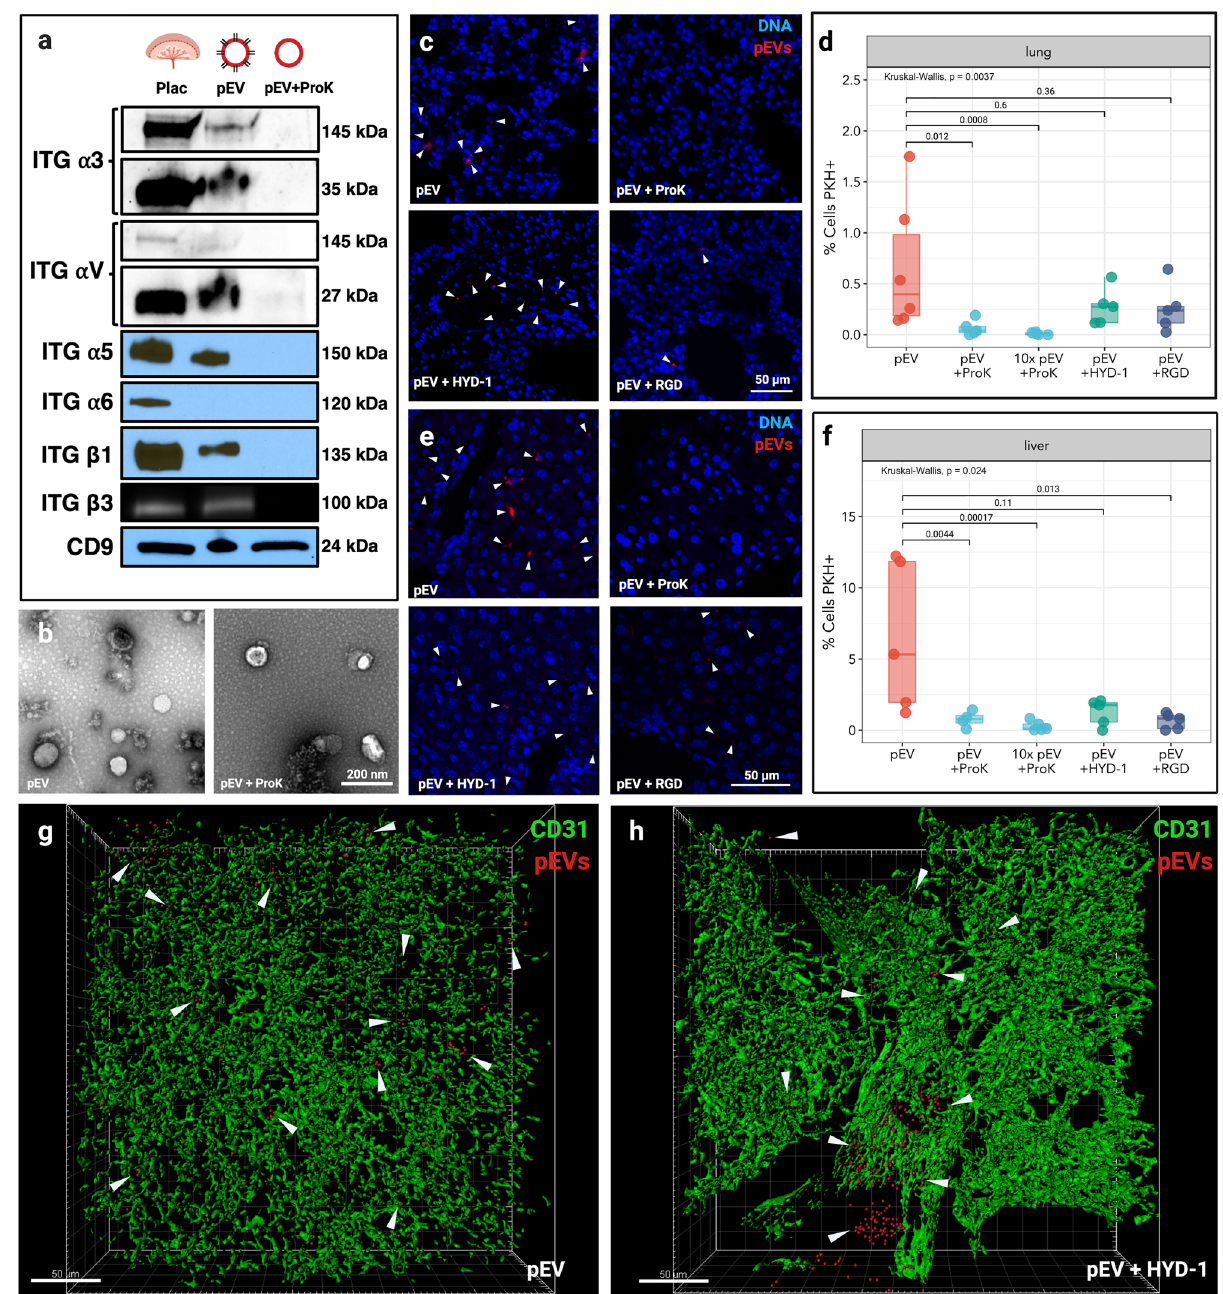
Figure 4. Integrins mediate placental EV localization to murine lung and liver. ( a ) Western Blot analysis of integrin expression in murine placenta, placental EVs (pEV), and placental EVs treated with proteinase K (pEV + proK). Representative image; n = 3. ( b ) Transmission electron microscopy of untreated EVs (left) or EVs treated with proteinase K (right). Representative image of n = 5; at least five random fields were examined per replicate. ( c ) Confocal microscopy of murine lung after treatment of mice with GD14.5 placental EVs (upper left), proteinase K-treated EVs (upper right), or EVs pre-incubated with HYD-1 (lower left) or RGD (lower right) peptides. Images are representative of five random fields from each animal. ( d ) Quantification of EV positive cells in lungs treated with placental EVs; n = 5–6 animals per treatement. ( e ) Confocal microscopy images of the liver after treatment of mice with placental EVs (upper left), proteinase K-treated EVs (upper right), or EVs pre-incubated with HYD-1 (lower left) or RGD (lower right) peptides. Images are representative of five random fields from each animal. ( f ) Quantification of EV-positive cells in liver of mice treated with placental EVs; n = 5–6 animals per treatment. ( g ) CUBIC-cleared lung from mouse treated with placental EVs. White arrowheads represent placental EV foci; n = 5. ( h ) CUBIC-cleared lung from mouse treated with HYD-1- pretreated EVs; n =